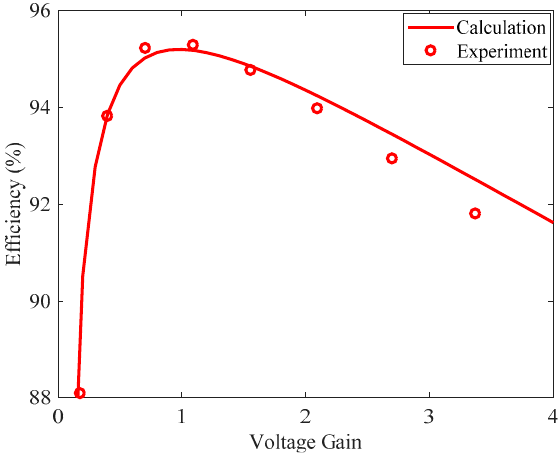
Figure 9. System efficiency varying with the voltage gain.